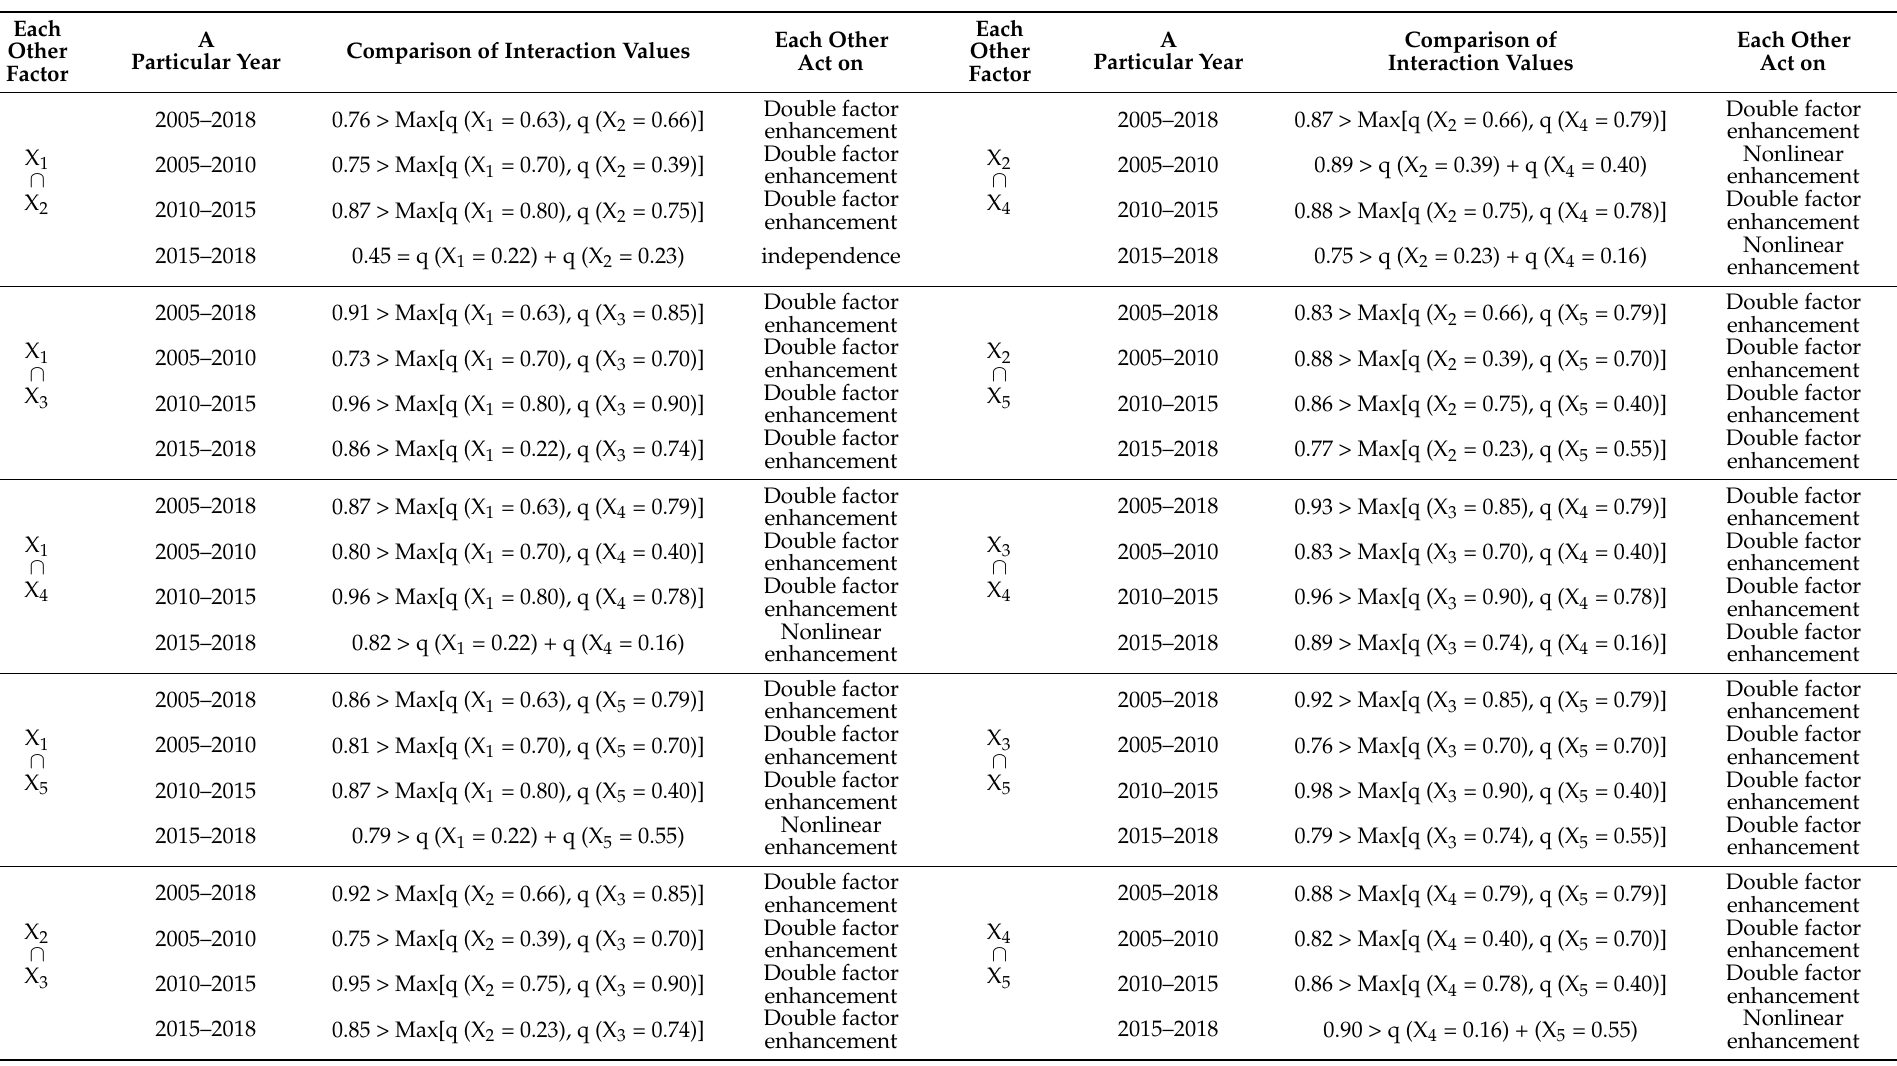
Table 4. Interaction detection results of the influencing